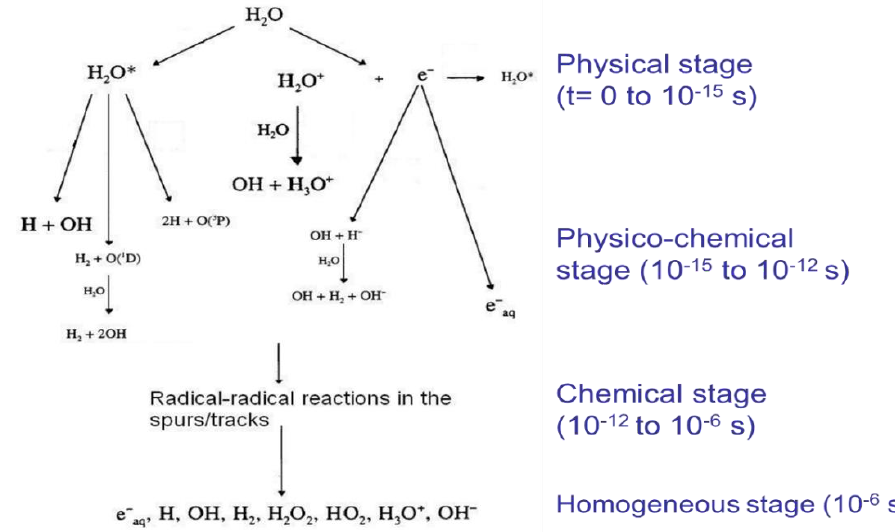
Figure 4. Processes occurring upon the interaction of ionizing radiation and a water molecule leading to the production of radiolytic species in solution. Figure prepared based on schemes for the radiolysis of water reported in refs